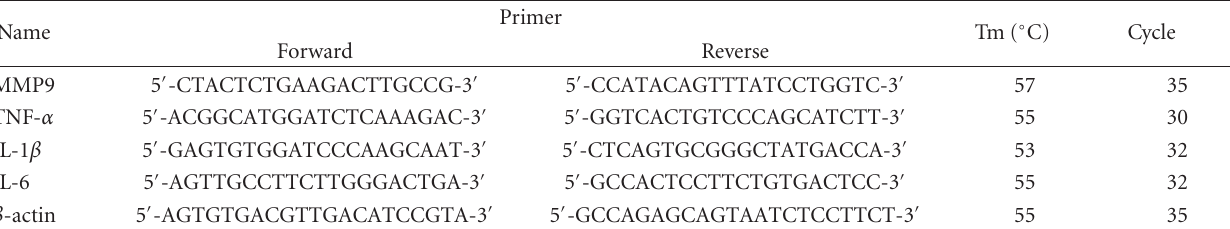
Table 1: Primers and parameters used in